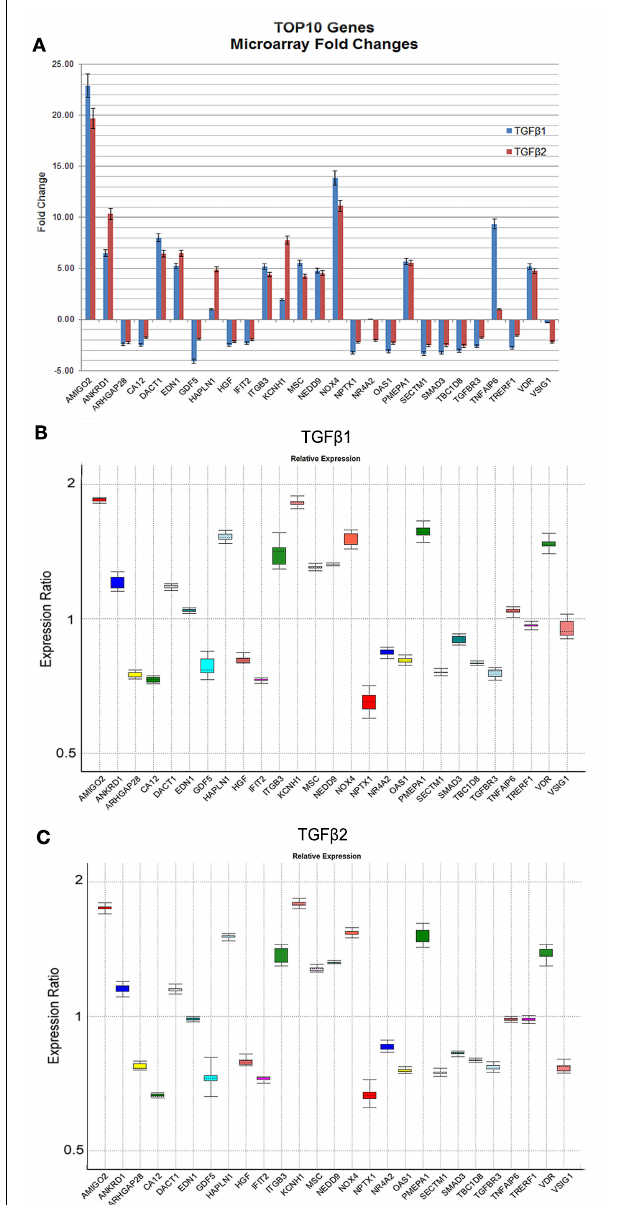
FIGURE 2 | Expression levels of the most significantly up- and downregulated genes based on microarray and qPCR analyses. The graphical representation of genes ( n = 27) displaying the most significant changes in expression patterns in response toTGF β stimulation with their FC values based on microarray analyses were shown (A) . OnlyTGF β 1 and TGF β 2 treatments were represented in (A) due to their statistically significant p -values detected by dChip. (B,C) Gene expression profiles of all 27 genes were independently validated using qPCR and data was analyzed using REST 2009 (Pfaffl et al., 2002). Expression variation for each gene was visualized in a whisker-box plot.Transcripts were sorted